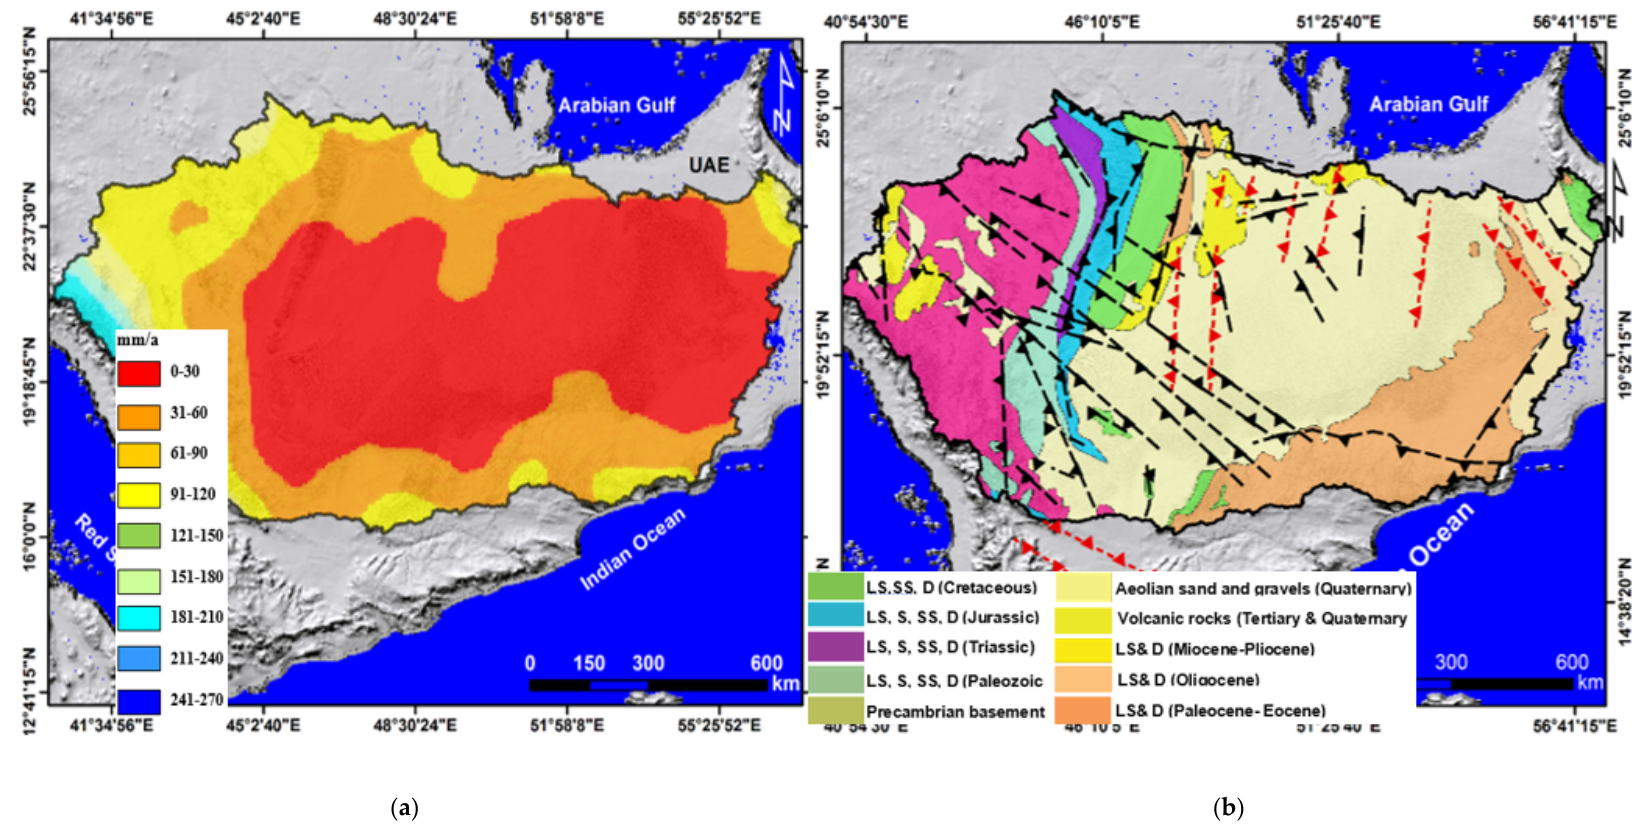
Figure 2. Maps of rainfall ( a ) and geology ( b ) showing the spatial distribution of precipitation and lithological and structural units across the ARAK mega-basin [2,3].